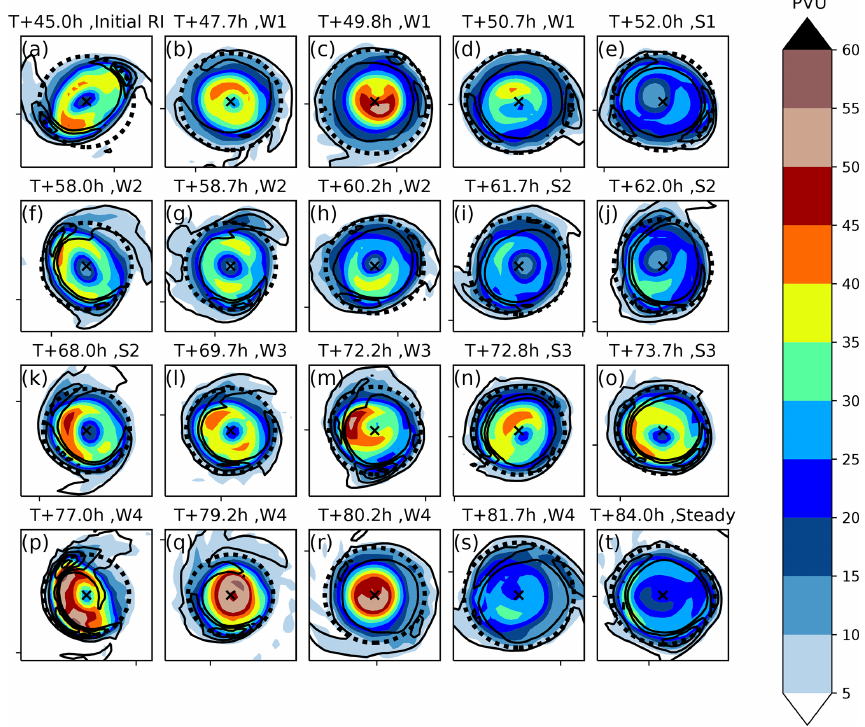
Figure 5. PV (PVU, shaded) at 1532m height for selected times and vertical velocity (1ms − 1 , black contour). The 1532m height RMW is indicated by the dashed black line. A cross marks the centre of the TC. The data are output in 10min intervals; times are given to the nearest 0.1h. The data are from ensemble member 15, which was initialised at 3 September 2017 at